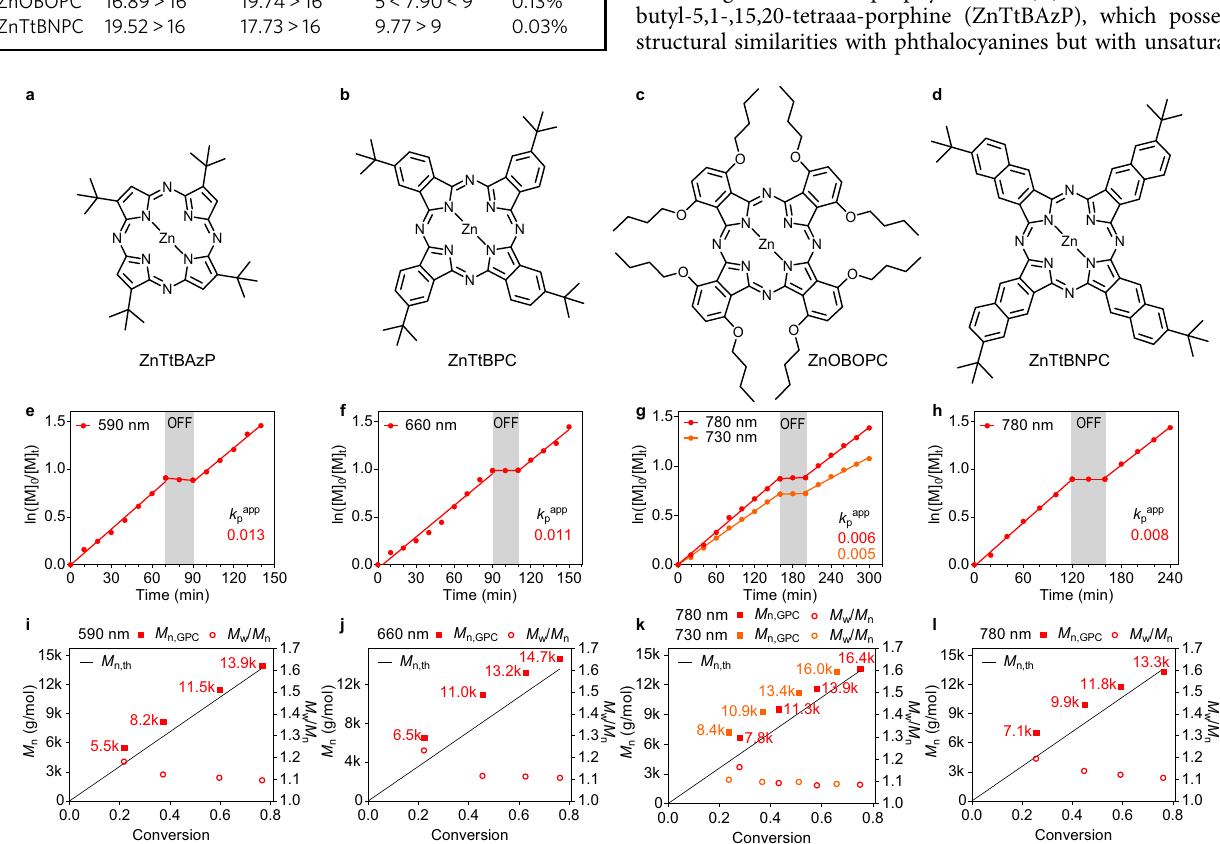
Fig. 5 Kinetic studies of PCs via O-RQP. a – d Molecular structure of ZnTtBAzP ( a ), ZnTtBPC ( b ), ZnOBOPC ( c ) and ZnTtBNPC ( d ). e – h Plot of ln([ M ] 0 / [ M ] t ) versus time revealing k p app and temporal control for model PET-RAFT polymerisation via O-RQP catalysed by ZnTtBAzP ( e ), ZnTtBPC ( f ), ZnOBOPC ( g ) and ZnTtBNPC ( h ), respectively. i – l M n (solid square) and M w / M n (hollow circle) versus monomer conversion analysed by gel permeation chromatography from aliquots taken at different time intervals during model PET-RAFT polymerisation via O-RQP catalysed by ZnTtBAzP ( i ), ZnTtBPC ( j ), ZnOBOPC ( k ) and ZnTtBNPC ( l ), respectively. Associated molecular weight distributions were provided as Supplementary Figs. 11 – 15. k p app : apparent propagation rate of polymerisation, the number of which is denoted aside the corresponding polymerisation slope with the same colour. Average molecular weights M n were denoted aside the corresponding points in i – l with the same